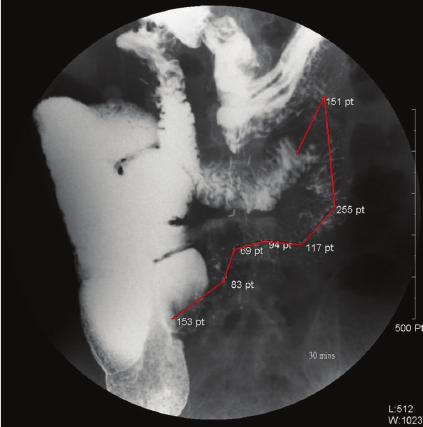
Figure 2: Low gastrointestinal series shows the thick and long colon and the abdomen full of the